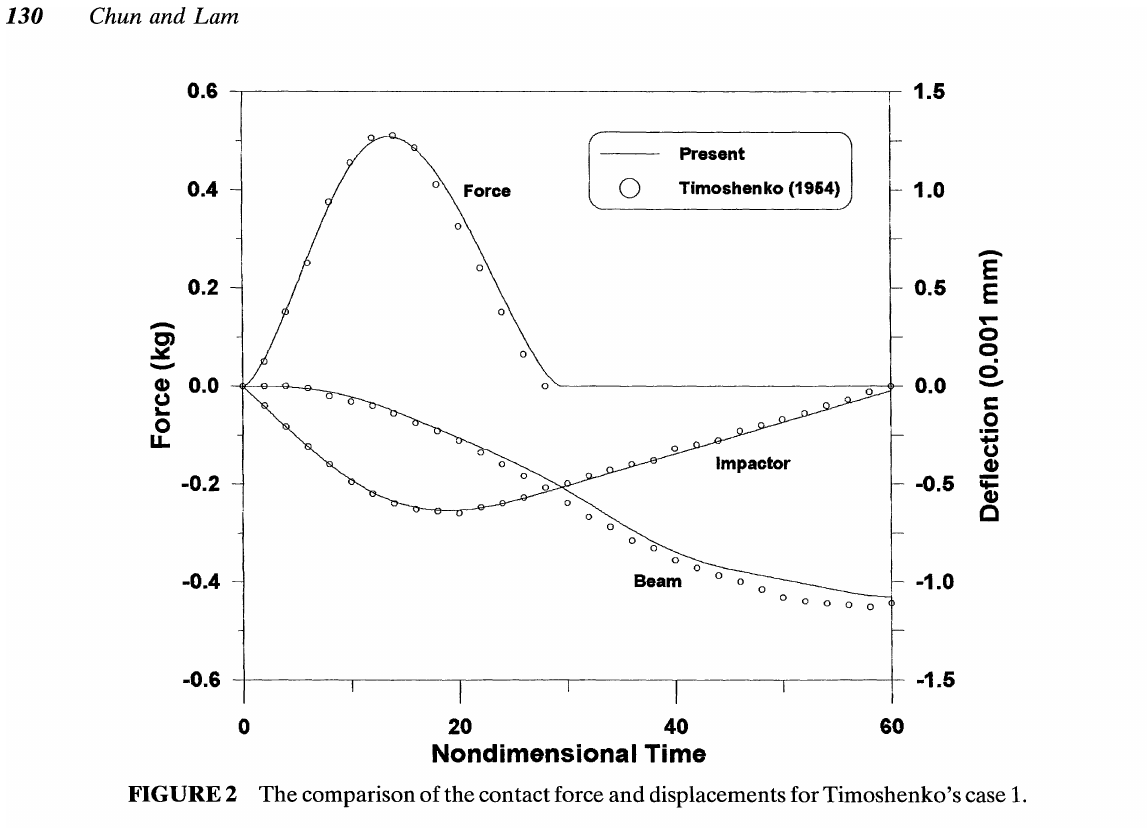
FIGURE 2 The comparison of the contact force and displacements for Timoshenko's case